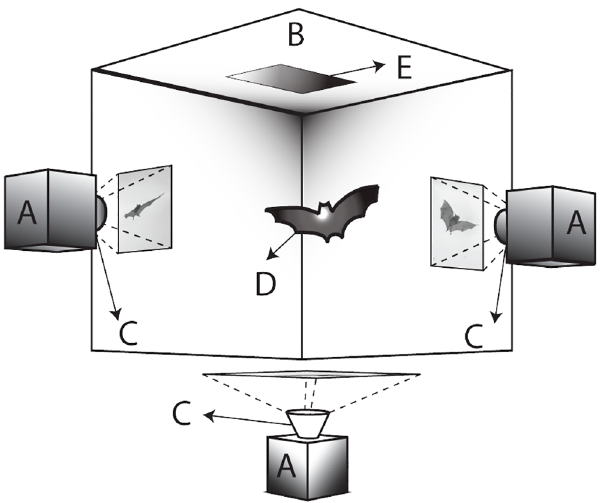
Fig 1. Apparatus for motion capture of landing bats. Videos are captured using three high-speed cameras (A) equipped with 50 mm lenses (C), at a frame rate of 1,000 frames per second. A uniform background (B) made of heavy-duty paper is placed behind the bat (D) to enhance contrast and visibility. The landing pad (E) is removed in order to generate a falling-and-recovery